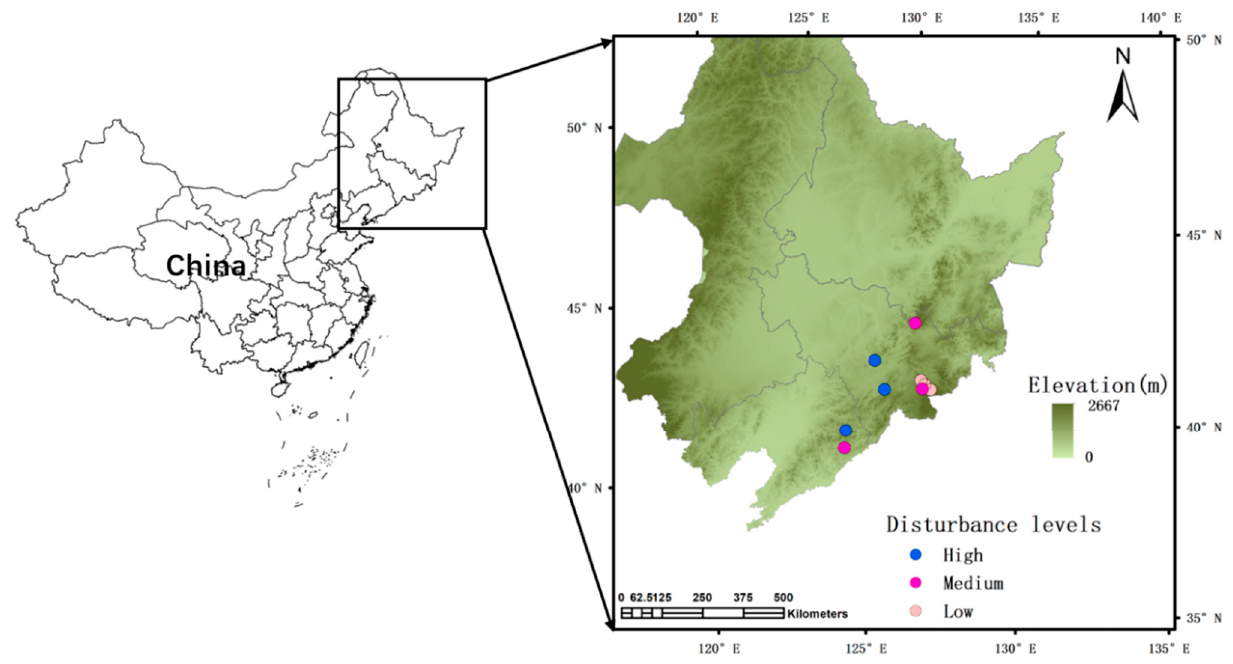
Figure 1. Map of China showing the study area and distribution of forest sites. The colors of dots represent disturbance levels at each site.